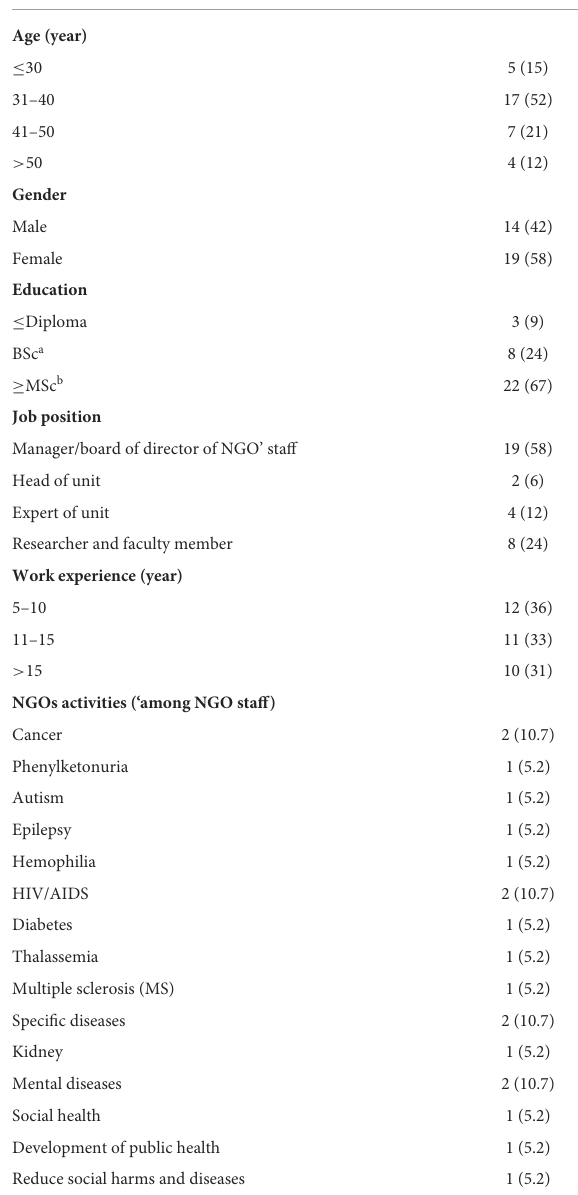
TABLE 1 Baseline characteristics of study